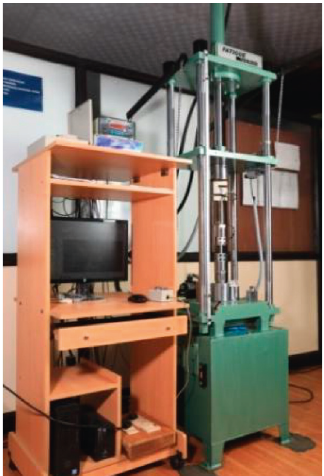
Figure 6: Hydraulic universal fatigue and creep testing machine (Model: